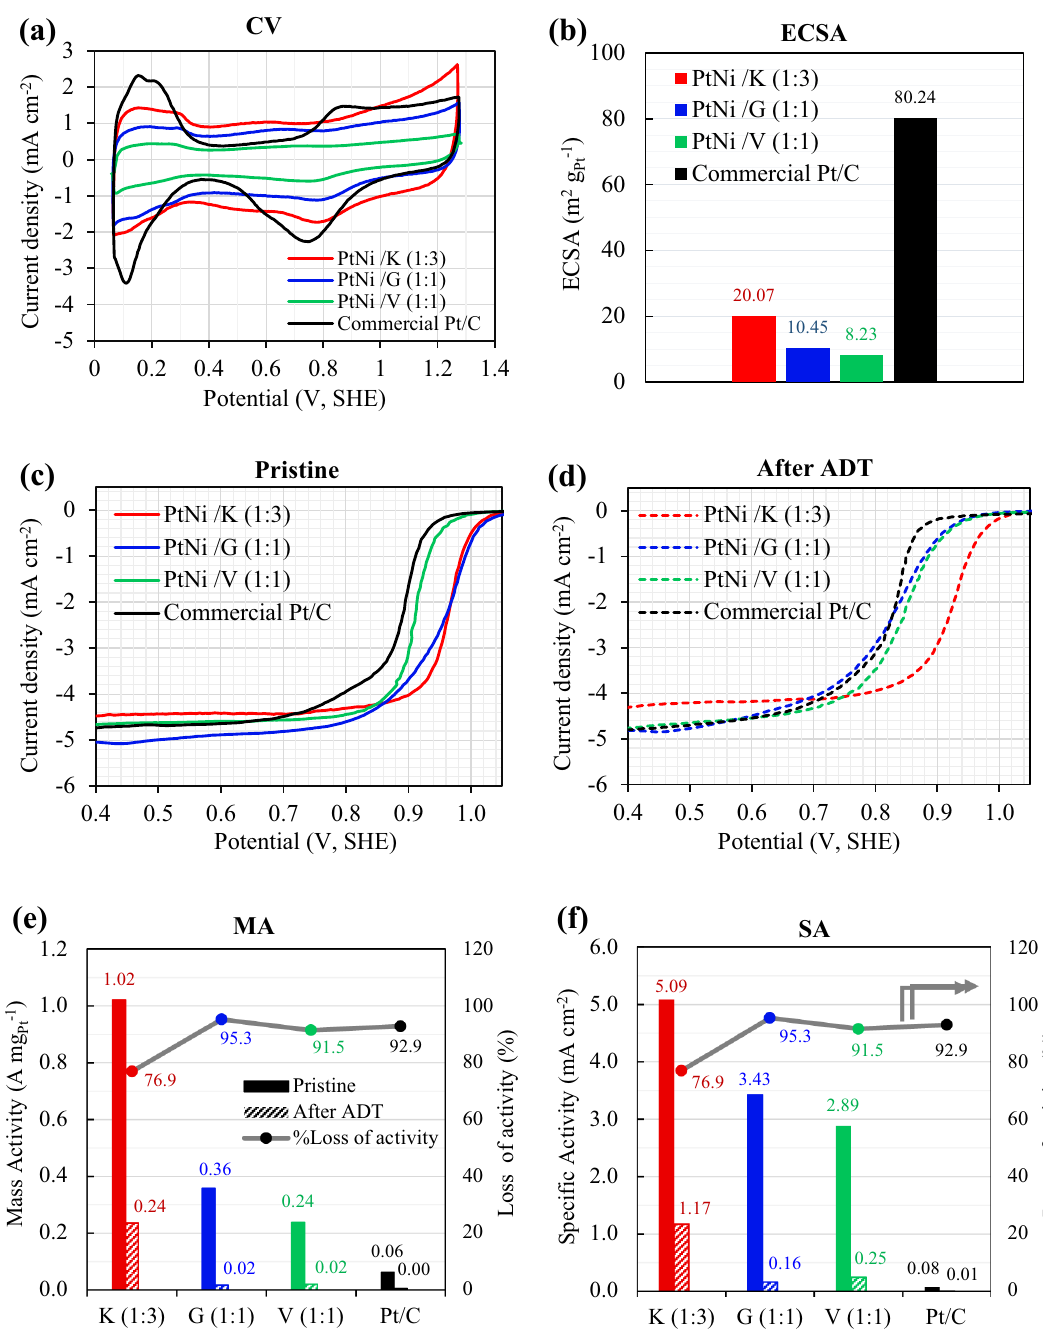
Figure 6. The voltammograms and electrochemical activities of Pt 3 Ni/C compared to commercial catalyst of 20 wt%. Pt/C: ( a ) cyclic voltammograms, ( b ) the ECSA, ( c ) and ( d ) linear sweep voltammograms of pristine and ADT samples, respectively, ( e ) mass activity (MA) and ( f ) specific activity